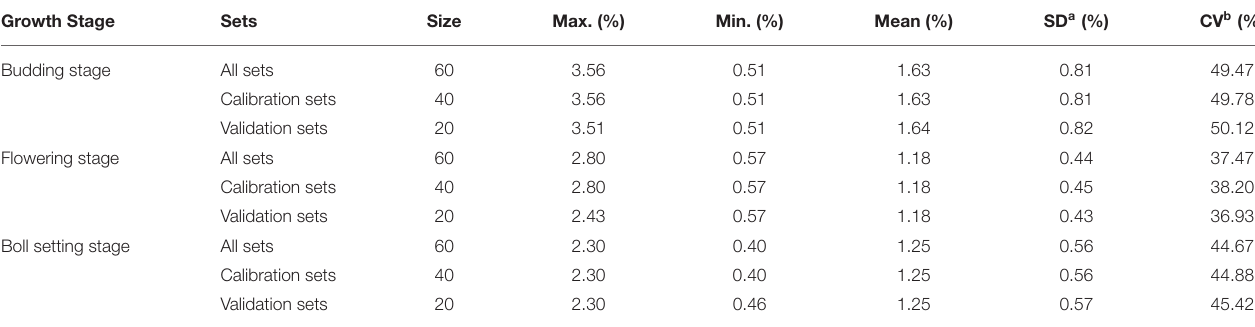
TABLE 2 | Statistical results of calibration and validation sets.